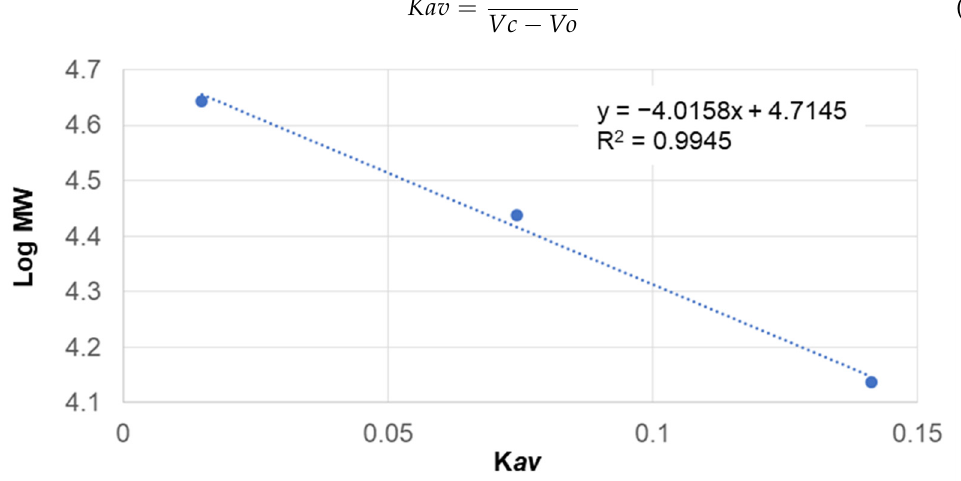
Figure 1. Gel Filtration Kit Calibration Low